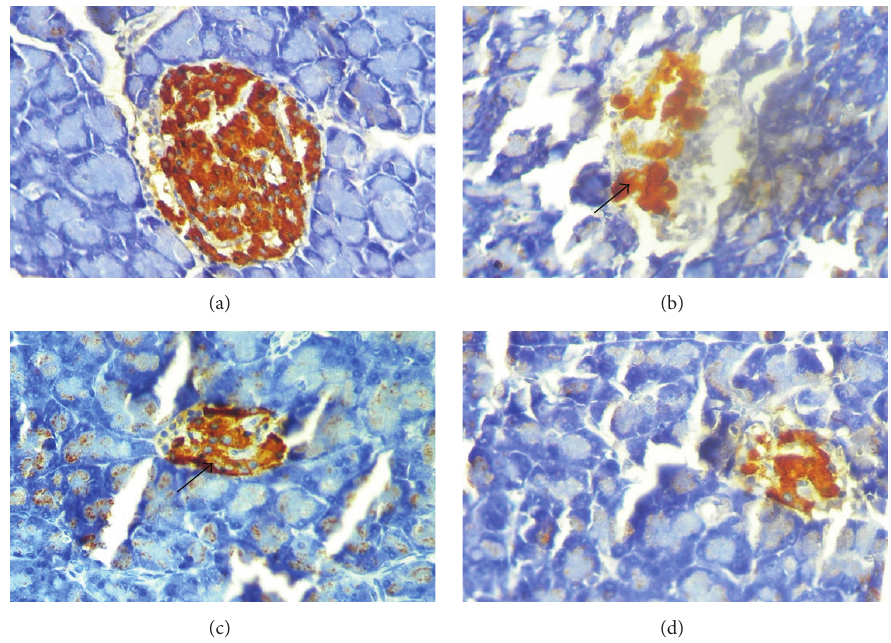
Figure 4: (a–d) Photomicrographs of insulin immune reactivity in pancreatic islets with anti-insulin antibody ( × 400). (a) Healthy control rats, a normal islet composed predominantly of insulin secreting cells. (b) Diabetic control rats, marked reduction in the number of insulin secreting 𝛽 -cells due to the destruction of islet cells by streptozotocin. (c) Gmelina arborea (1.00g/kg) treated (1.00 g/kg) rats, an islet with a marked increase in insulin secreting 𝛽 -cells. (d) Glibenclamide treated (0.50 mg/kg) rats, mild increase in insulin secreting 𝛽